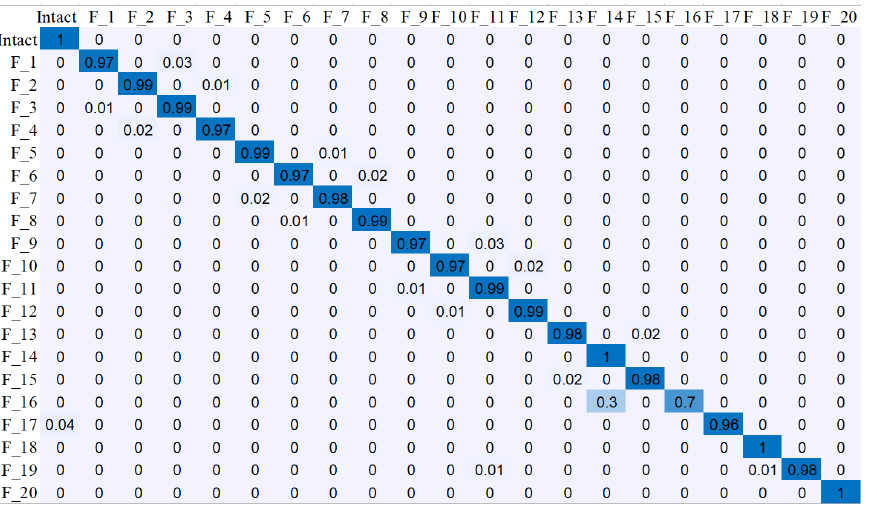
Figure 17. Confusion matrix of the different environmental condition (Hs = 3 m, Tp = 8 sec) (Accuracy: 97.0%).